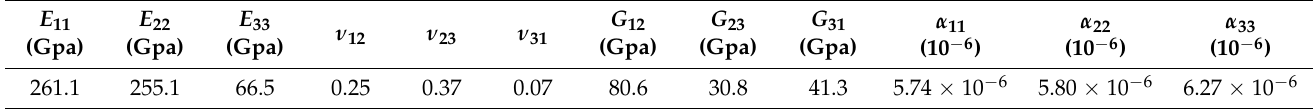
Table 10. The equivalent thermoelastic parameters.